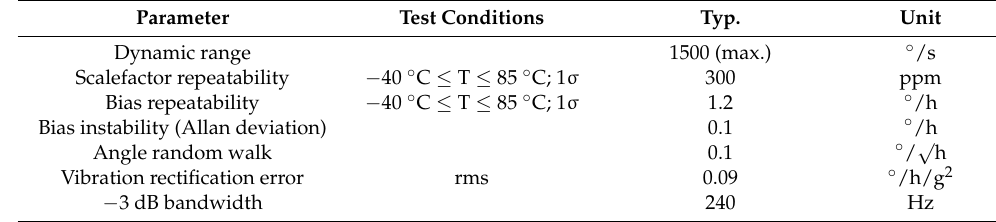
Table 2. Typical values achieved by single-axis MEMS gyroscopes for the use in the Northrop Grumman LITEF MEMS IMU. All parameters tested on the IMU